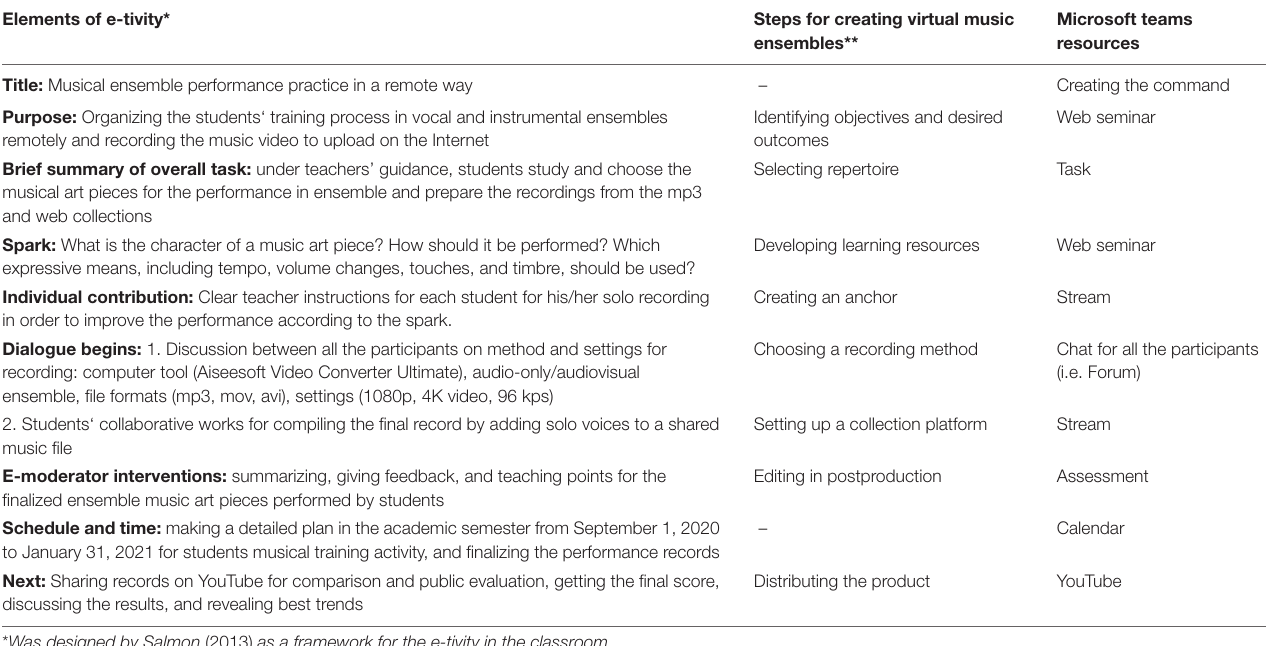
TABLE 1 | Elements of e-tivity for creating a virtual ensemble by means of Microsoft Teams resources. Elements of